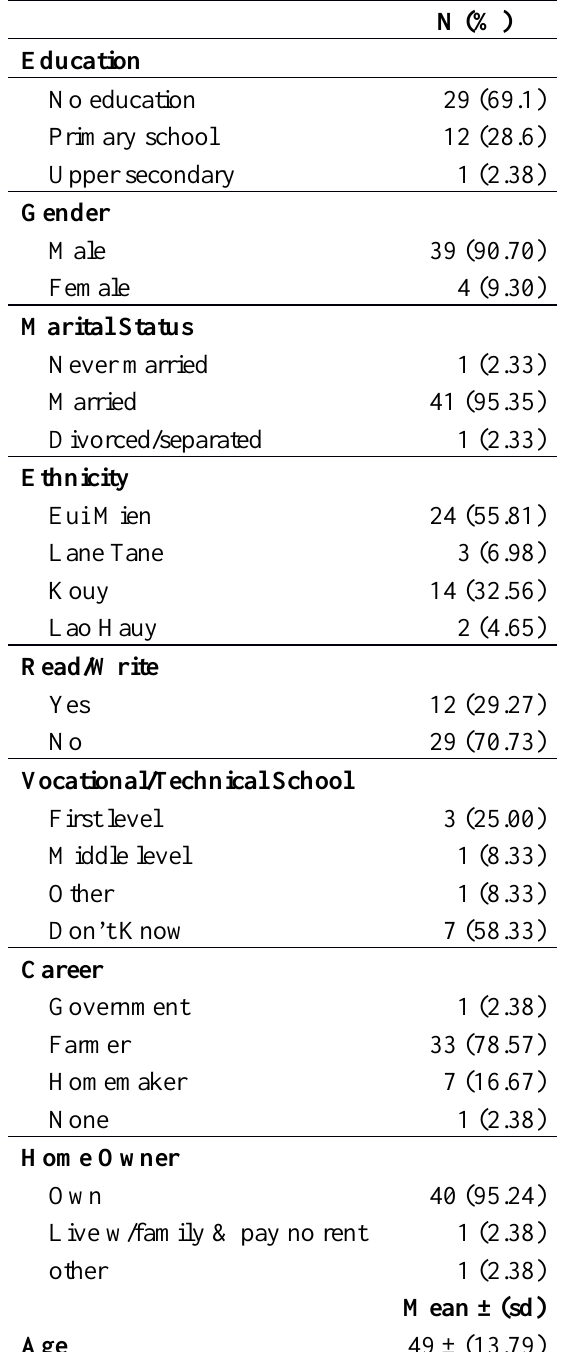
Table 1. Demographics of 43 tobacco waterpipe smokers of rural Lao PDR (Luang Namtha Province, 2010).